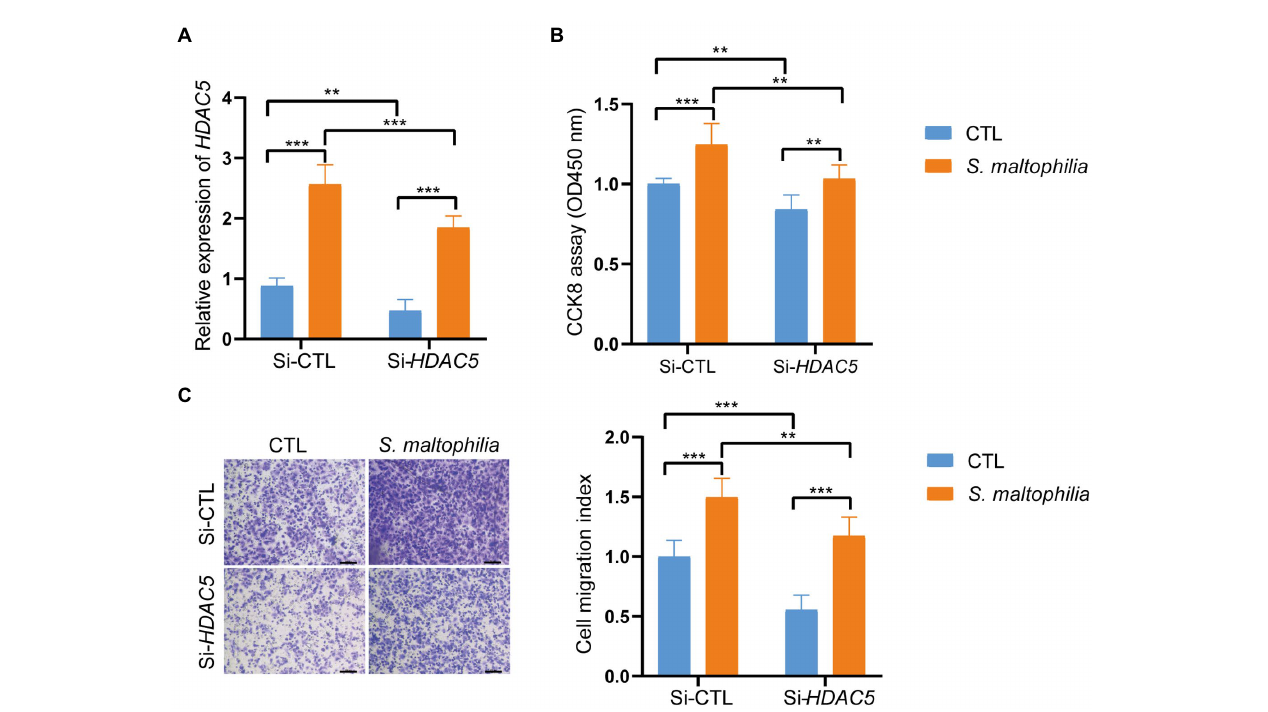
FIGURE 6 Inhibition of HDAC5 suppressed lung cancer cellular functions. Lung cancer cells A549 were transfected with si-HDAC5 or negative control (si-NC). (A) The HDAC5 expression levels were detected by qRT-PCR. (B) CCK-8 assay was used to test the cell proliferation. (C) Transwell migration assay was used to test the cell migration ability. * p < 0.05, *** p < 0.001 by Student’s